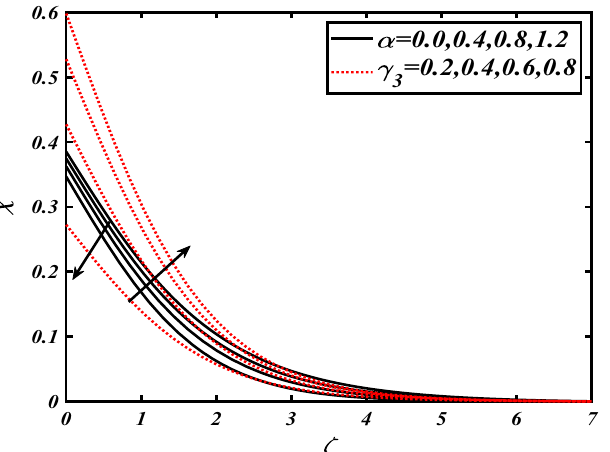
Figure 12. Illustration of α and γ 3 over motile microorganisms χ when Rd = 0.4, γ 2 = 0.3, γ 1 = 0.3, Nt = 0.3, Nb = 0.2, Nr = 0.2, S = 0.5, (cid:31) = 0.5, Pe = 0.1, Lb = 2.0